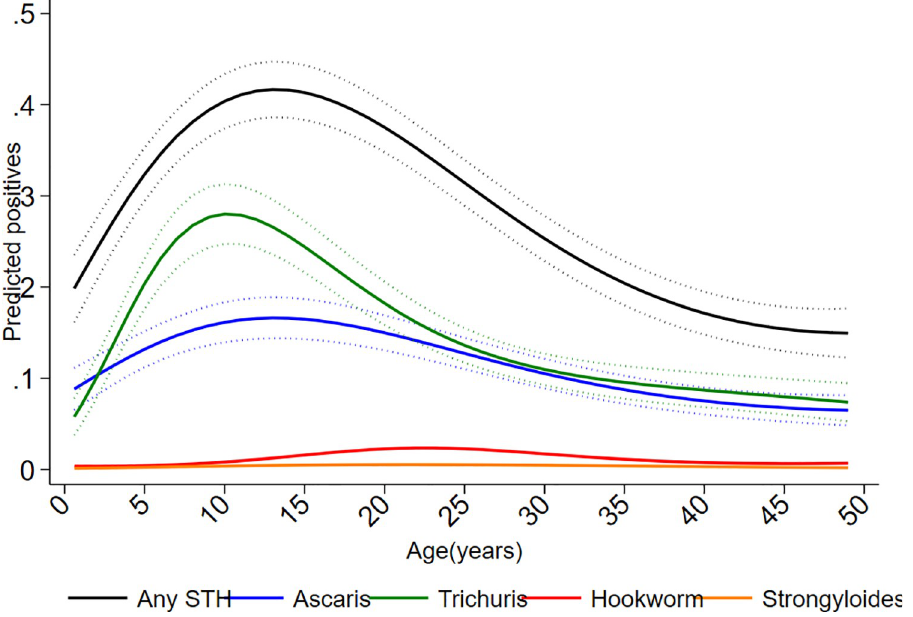
Fig 4. Age-dependent risk of infection with any soil-transmitted helminth (STH) and individual STH parasites inferred from household data collected at the time of recruitment of the ECUAVIDA cohort. Age-dependent proportions (and 95% confidence intervals) of positives were predicted using two-level logistic regression fitted to a binomial response accounting for household clustering. Age modelled using a 5 th degree polynomial. The data consist of samples collected from household members at the time of recruitment of the cohort.